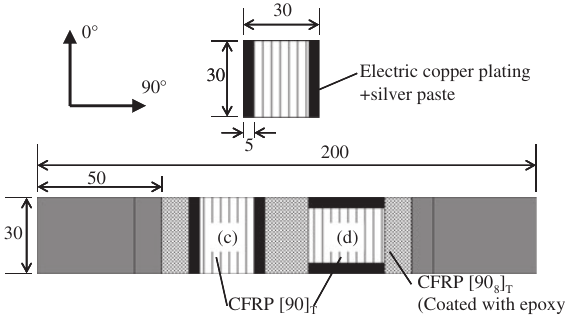
Figure 2 Confi gurations of specimens (c) and